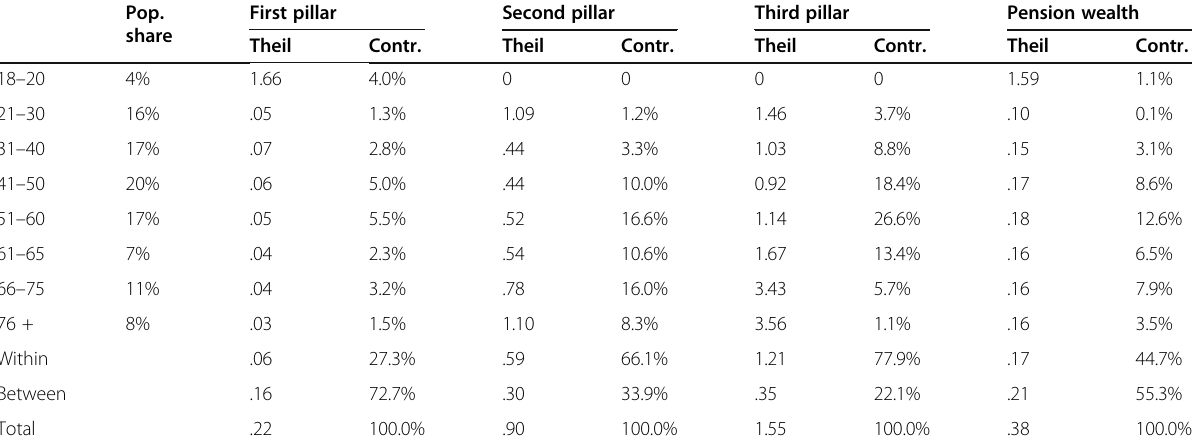
Table 2 Decomposition of individual pension wealth in 2015 by age groups Pop. First pillar Second pillar Third pillar Pension wealth share Theil Contr. Theil Contr. Theil Contr. Theil